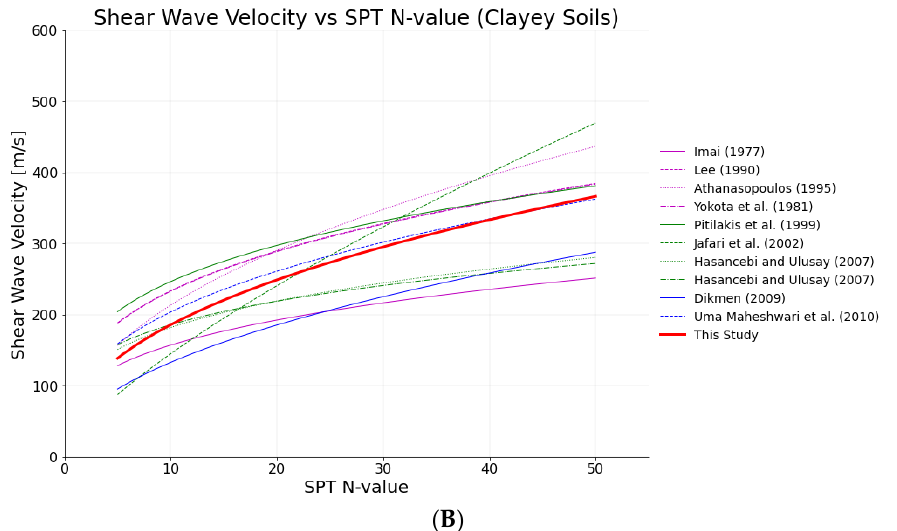
Figure 6. ( A ). Uncorrected SPT-N and V s pairs for clayey soils and the determined empirical correlation. ( B ) . Comparison of the proposed empirical correlation for clayey soil types and other published works [14,22,23,28,30,35,60,61,66].